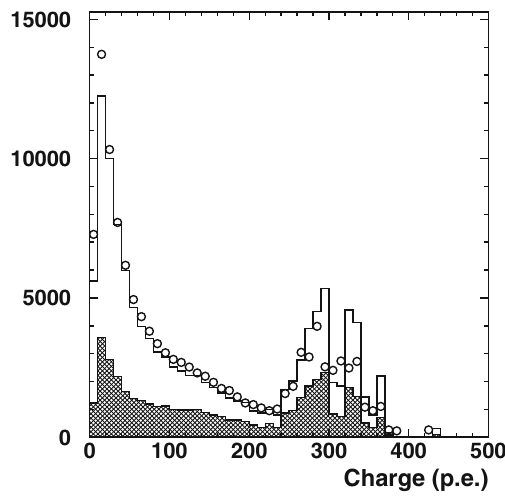
Fig. 23 The largest charge in a PMT for an event. Events that have a charge less than 200 p.e. are considered FC events. The rest are PC events. Data are the circles and MC is the histogram. The data have only statistical errors